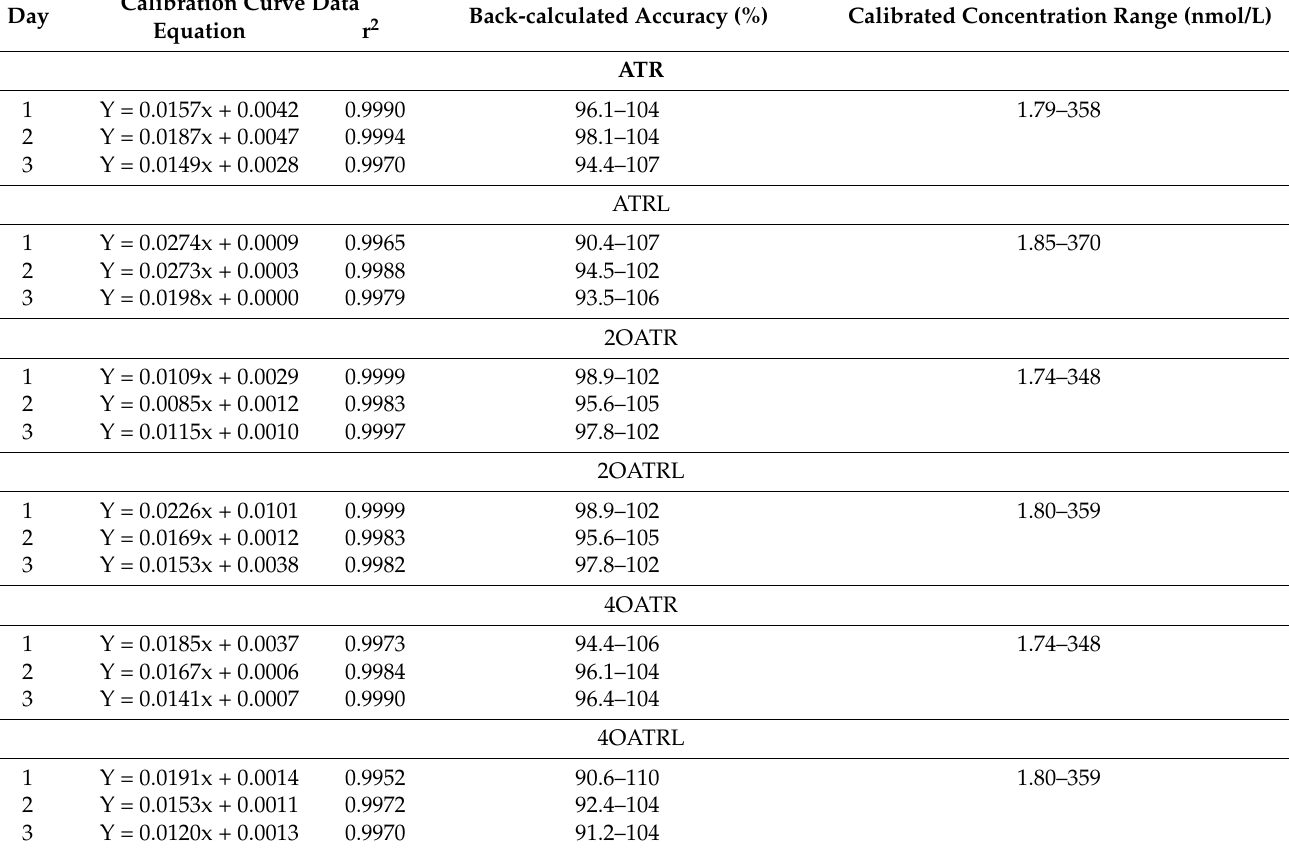
Table 1. Calibration curve data obtained on 3 separate days. 6 point calibration was employed using weighted linear regression with 1/x 2 -weights. ATR, atorvastatin. ATRL, atorvastatin lactone. 2OATR, 2-hydroxyatorvastatin. 2OATRL, 2-hydroxyatorvastatin lactone. 4OATR, 4-hydroxyatorvastatin. 4OATRL, 4-hydroxyatorvastatin lactone. r 2 , determination